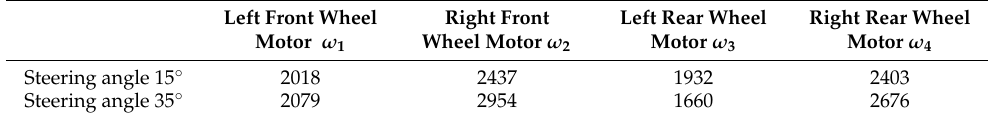
Table 2. Differential speed of each drive motor when the loader is empty (6 km/h) (unit: rpm).